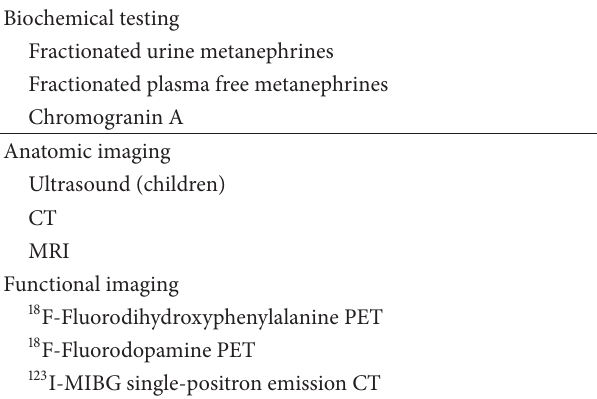
Table 1: Work-up of suspected